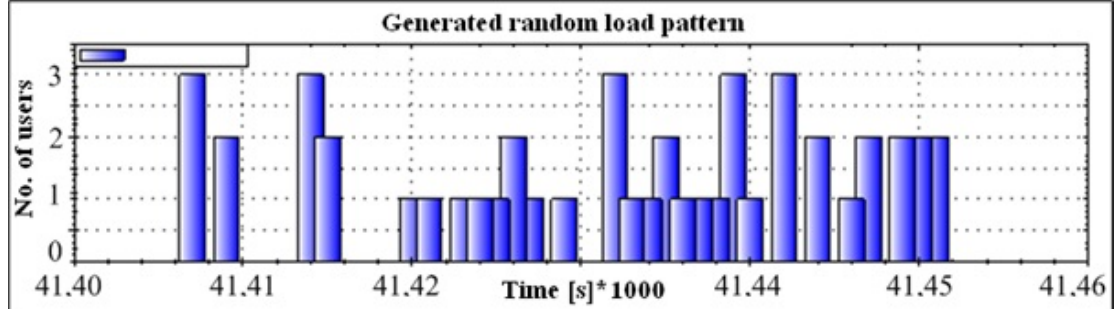
Figure 12. A random load pattern for a charging service system for the number of users U = 47.